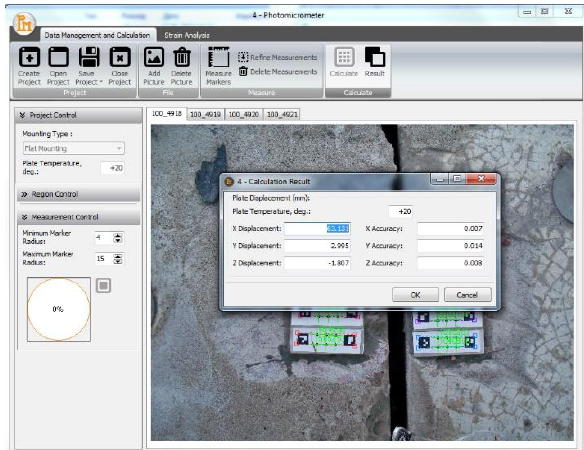
Figure 10. Computation of the relative position of the blocks of marks, accuracy assessment